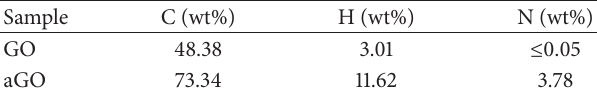
Table 1: The elemental analysis results of GO and aGO.